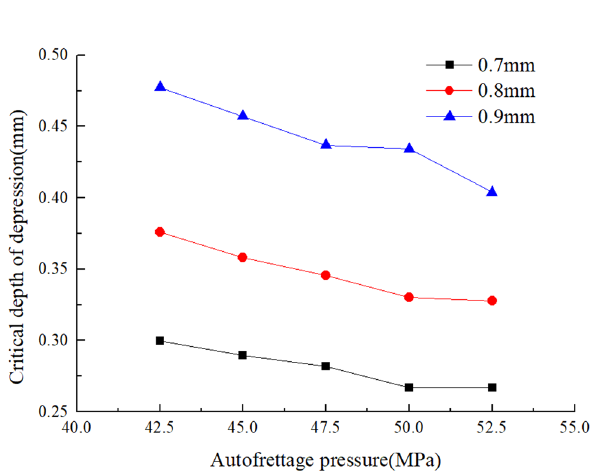
Figure 7: Relationship between the critical depth of depression and autofrettage pressure considering the variation of liner thickness.